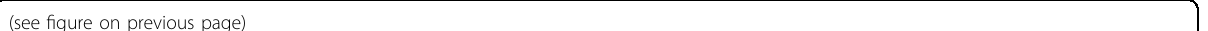
Fig. 1 AcrVA5- and CobB-mediated reversible regulation of Cas12a activities through acetylation and deacetylation. a The LbCas12a cis - cleavage experiment with target dsDNA. As illustrated below, active Cas12a successfully cleaved target dsDNA into two pieces by with the guidance of crRNA, however, acetylated Cas12a became inactivated and lost the cis -cleavage activities against target dsDNA. M, 1-kb DNA ladder (Thermo Fisher Scienti fi c); S, dsDNA substrate; P, Cas12a cis -cleaved products. b The LbCas12a trans -cleavage experiment with target dsDNA. As illustrated below, the trans -cleavage activities of active Cas12a proteins were triggered by target dsDNA, trans -cleaving the fl uorescence-quencher reporter (FQ- reporter), and illuminating fl uorescent signals. However, once Cas12a was acetylated, it became inactivated and lost the trans -cleavage activities in the presence of target dsDNA. Fluorescence signal was collected with a real-time qPCR machine and values were shown with background signal subtracted. NC, the negative control reaction with no target added; LbCas12a, reaction using untreated LbCas12a; LbCas12a-AcCoA, reaction using LbCas12a treated with acetyl-CoA only; LbCas12a-AcCoA-AcrVA5, reaction using LbCas12a treated with AcrVA5 at the presence of acetyl-CoA; acLbCas12a, AcrVA5-acetylated LbCas12a; acLbCas12a-NAD + , acetylated LbCas12a treated with NAD + only; acLbCas12a-NAD + -CobB, acetylated LbCas12a treated with CobB at the presence of NAD + . c Analysis of the physiological role of CobB in protecting the host from invading foreign apr reporter plasmid. W3110/cas12a, the wild type expressing the LbCas12a/crRNA complex; Δ cobB, the cobB null mutant expressing the LbCas12a/ crRNA complex; W3110/cobB + cas12a, the wild type expressing the LbCas12a/crRNA complex as well as the CobB. apr-WT, reporter plasmid with the wild type apr gene; apr-Mut, reporter plasmid with the mutant apr gene that can escape from the cleavage by Cas12a. d A regulatory model of AcrVA5- and CobB-mediated reversible regulation of Cas12a activities. The acetyltransferase AcrVA5 uses acetyl-CoA to acetylate Cas12a, inactivating Cas12a as well as the host resistance system against MGEs, however, the host possesses the NAD + -dependent CobB, which deacetylates and reactivates Cas12a and provides the host a secondary safeguard to the invading nucleic